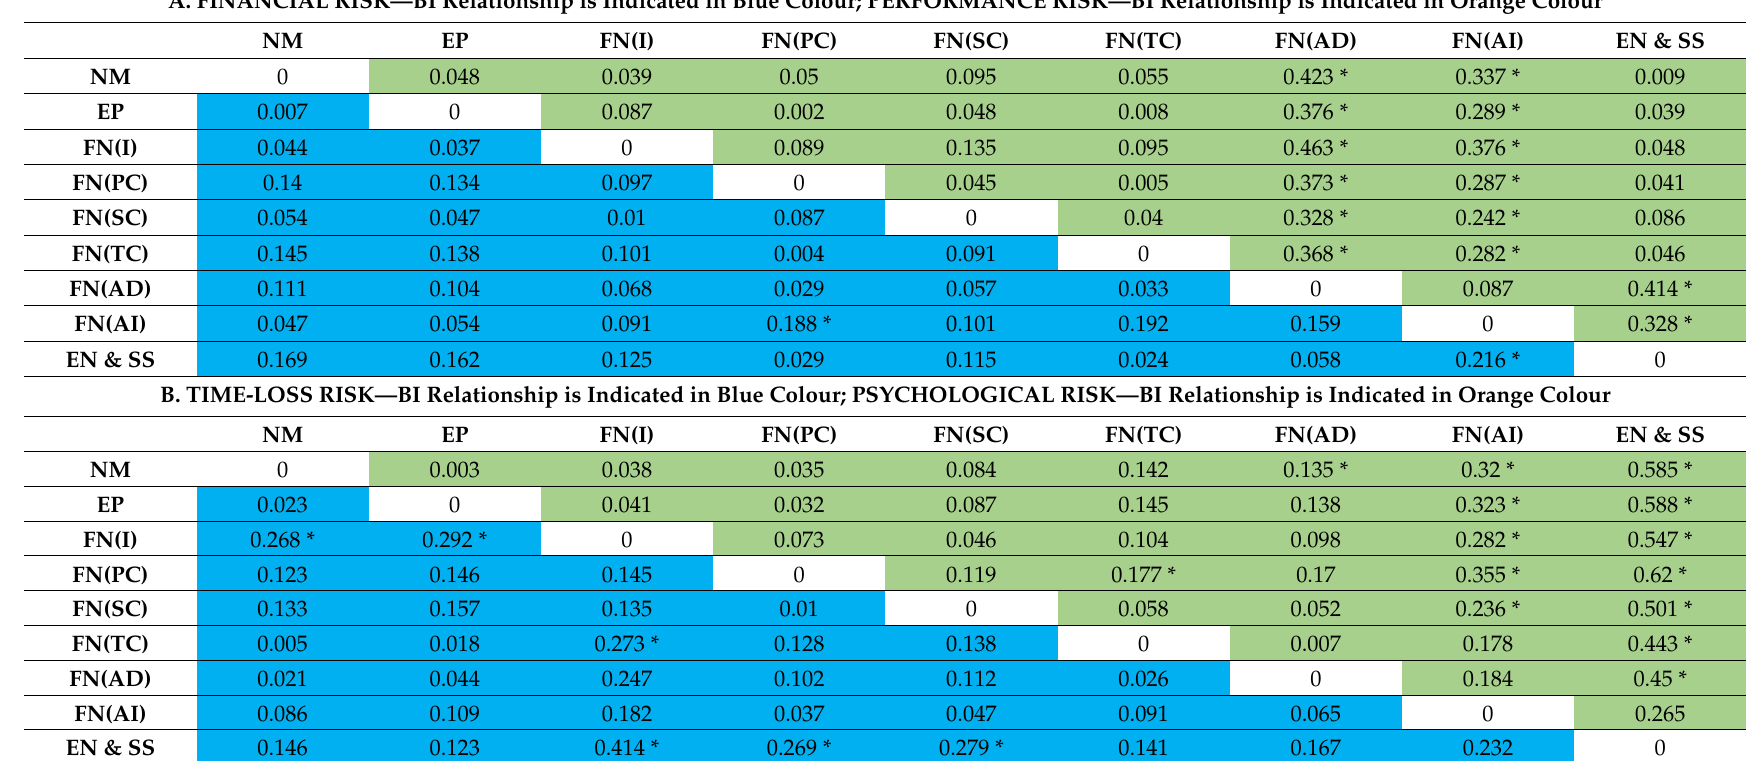
Table 5. PLS-Multi-Group analysis (MGA)